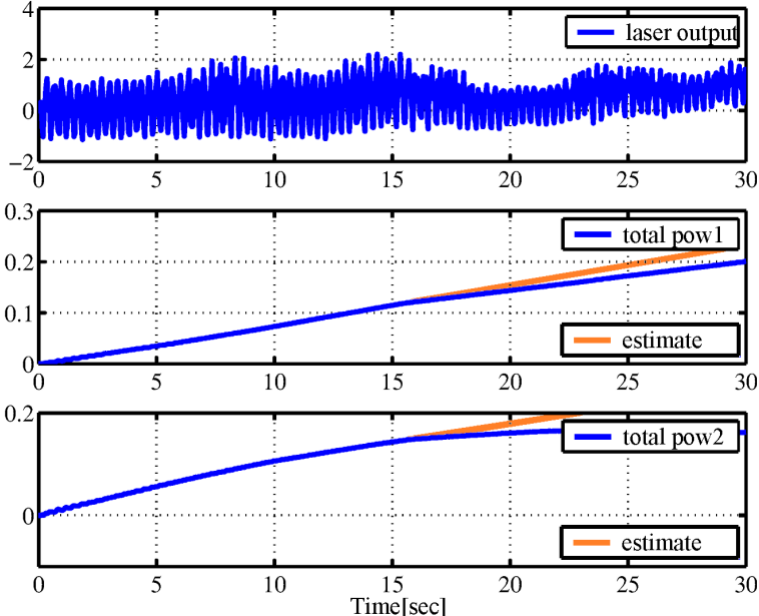
Figure 8. Experimental Results on Detecting Dynamical Changes